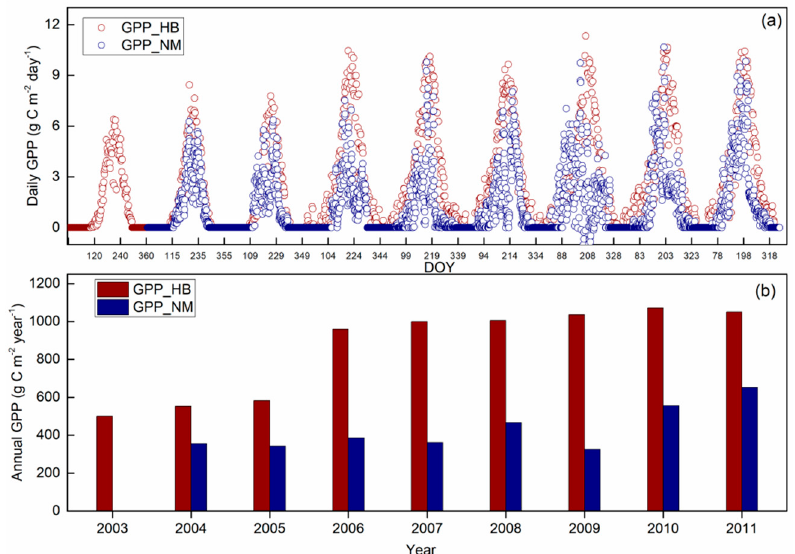
Figure 3. Seasonal ( a ) and interannual dynamics ( b ) of EC-based gross primary productivity (GPP) in Haibei (HB) and Inner Mongolia (NM) grassland stations from 2003 to 2011.